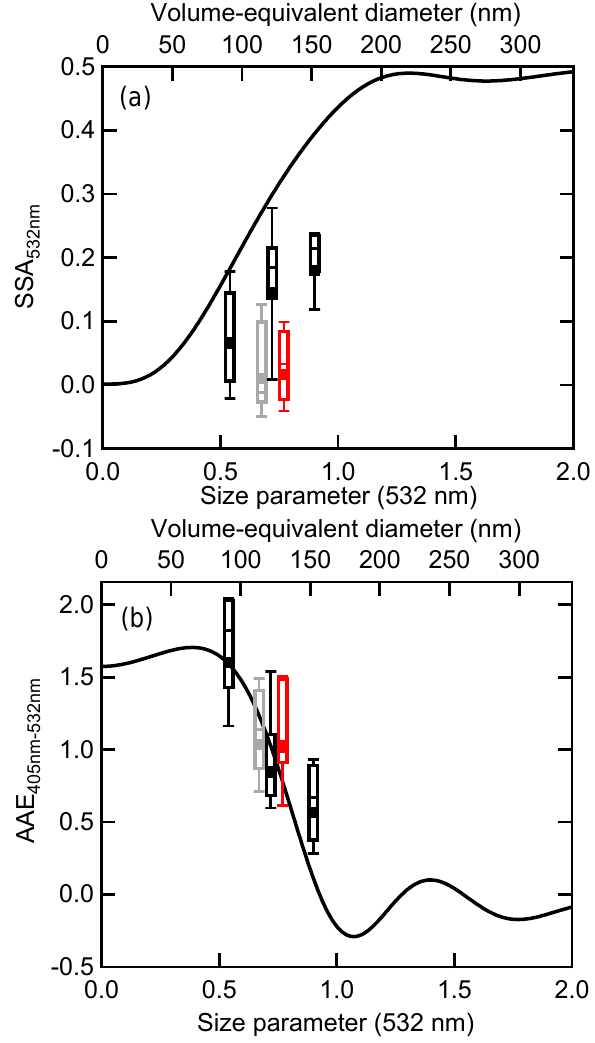
Figure 6. Box and whisker plots of (a) single-scattering albedo (SSA) and (b) absorption Ångström exponent (AAE) as a func- tion of size parameter and volume-equivalent diameter produced from the ethylene flame during BC2. The SSA was calculated us- ing data from the NOAA PAS, and the AAE was calculated us- ing data from the λ = 405nm PASS-3 and the λ = 532nm NOAA PAS data. The black points are coated–denuded data (coating ma- terial is evaporated following coating with DOS or sulfuric acid) and are potentially collapsed due to coating, and the gray points are nascent–denuded points (evaporation of intrinsic organic matter produced from the ethylene flame). The black lines are the SSAs predicted using spherical particle Mie theory using the effective complex refractive index retrieved from fitting the σ abs,532nm from the NOAA PAS. Here points are binned with a constant (cid:49)x = 0 . 18 for the purpose of comparison between the different particle treat- ments. N = 6 for nascent or nascent–denuded points, N = 5 for DOS coated–denuded points, and N x = 0 . 54 = 11, N x = 0 . 72 = 8, and N x = 0 . 9 = 5 for H 2 SO 4 coated–denuded